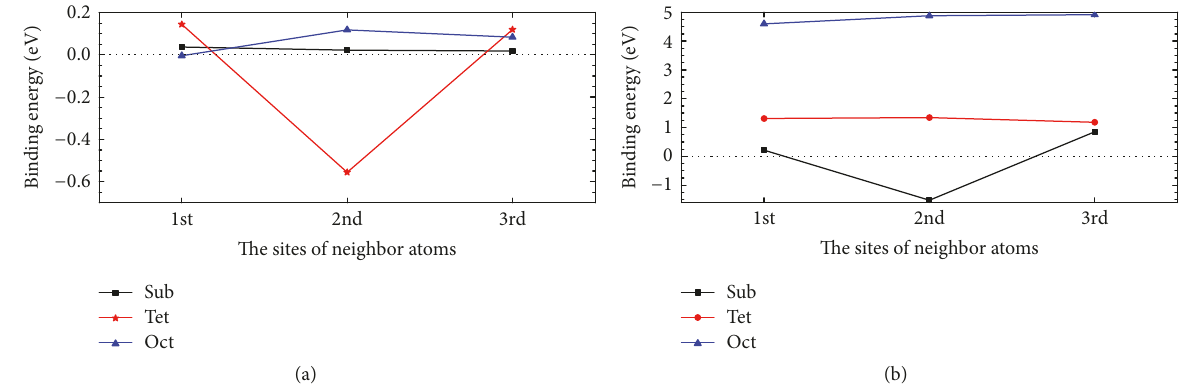
Figure 6: The binding energy of two H (a) and He (b) atoms in W when they are located in different positions and the distance of two H and He atoms is